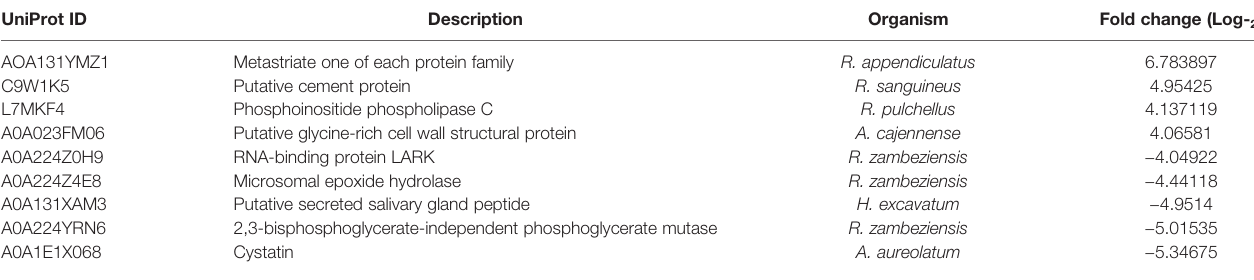
TABLE 2 | Proteins identi fi ed in the midgut of R. sanguineus from the tropical lineage vs. R. sanguineus female from temperate lineage identi fi ed only in the infection condition, with log 2 -normalized fold-change ≤− 4 or ≥